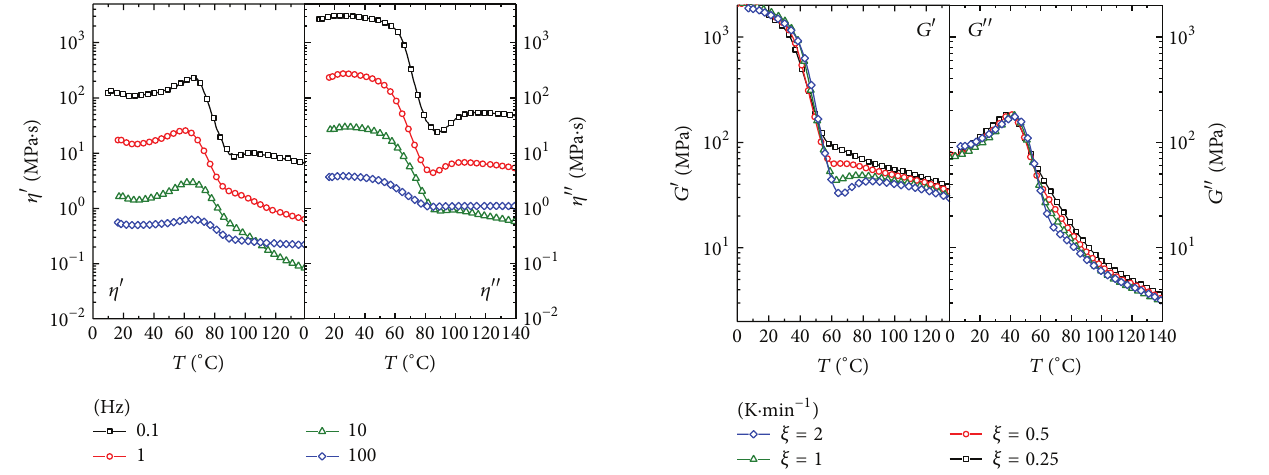
Figure4:Temperaturesweeptestsatdifferentfrequencies:variation of dynamic and out-of-phase viscosities with temperature.